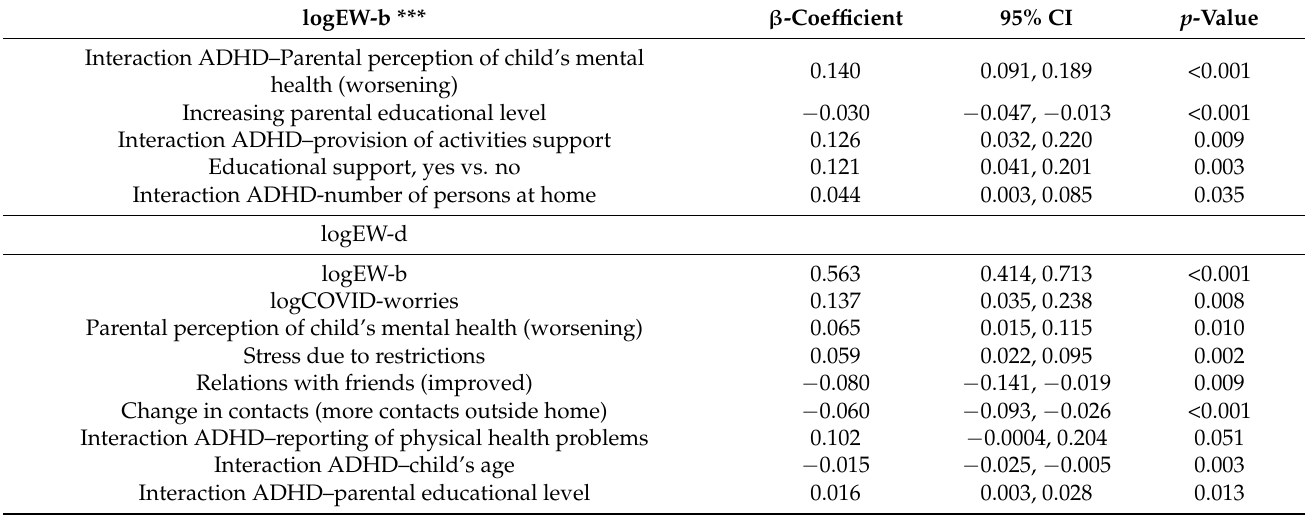
Table 2. SEM * on logEW-d **. Results are presented as β -coefficients, 95% confidence intervals (CI) and p -values.